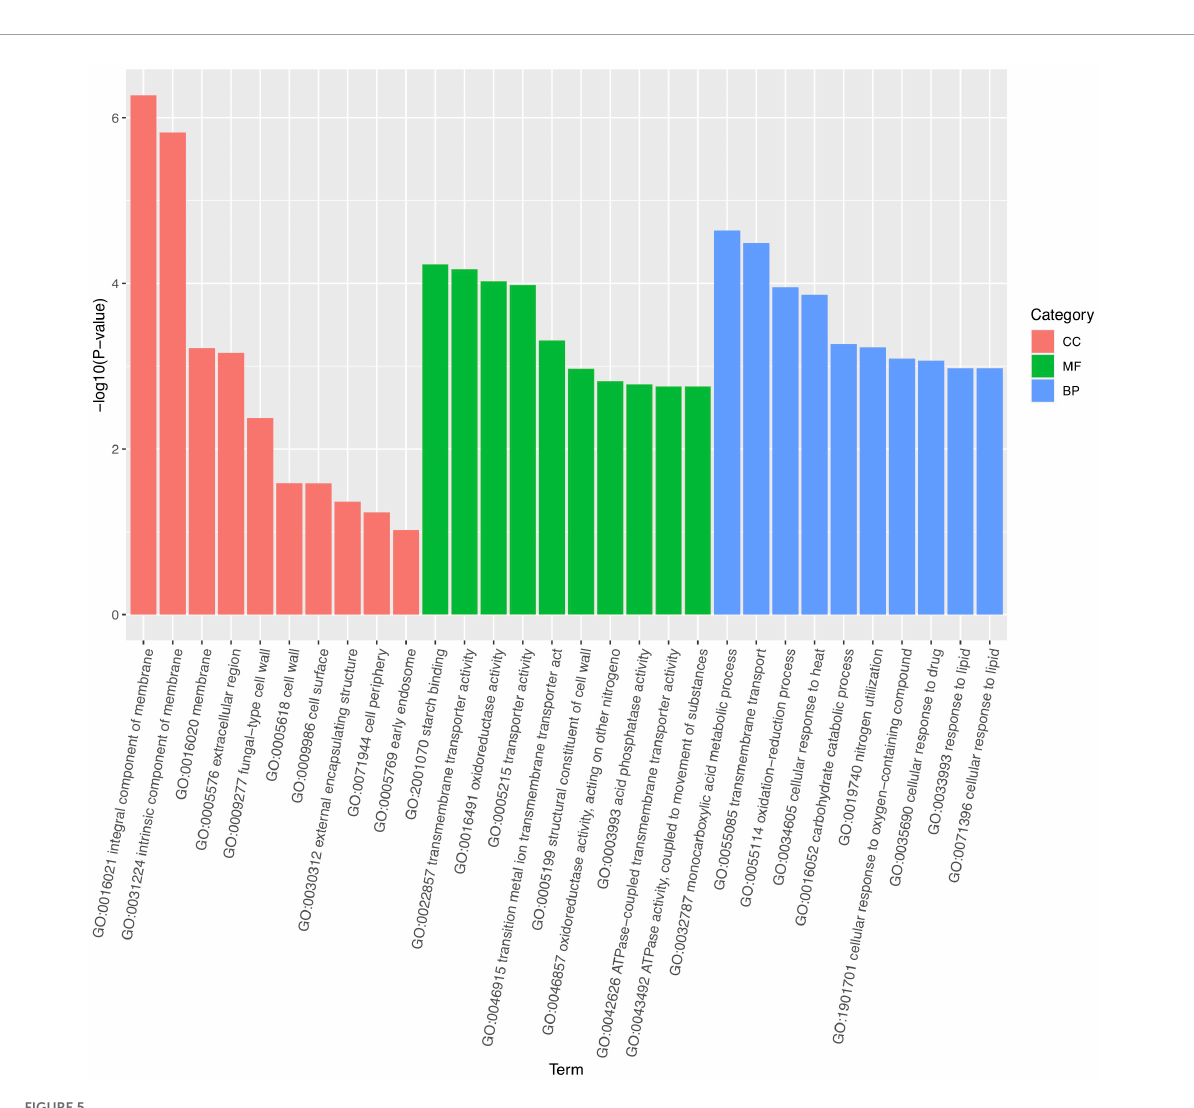
FIGURE5 Gene ontology (GO) functional annotation and classification of expressed genes (fold change > 1) between Penicillium olsonii WHG5 (control; WHG5 cultured without Bacillus velezensis metabolites) and WHG5_FL (treatment; WHG5 cultured with B. velezensis